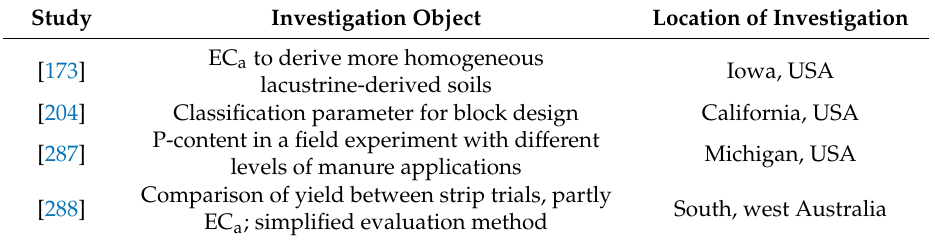
Table 8. Applications of EM38-EC a for improving the efficiency of field